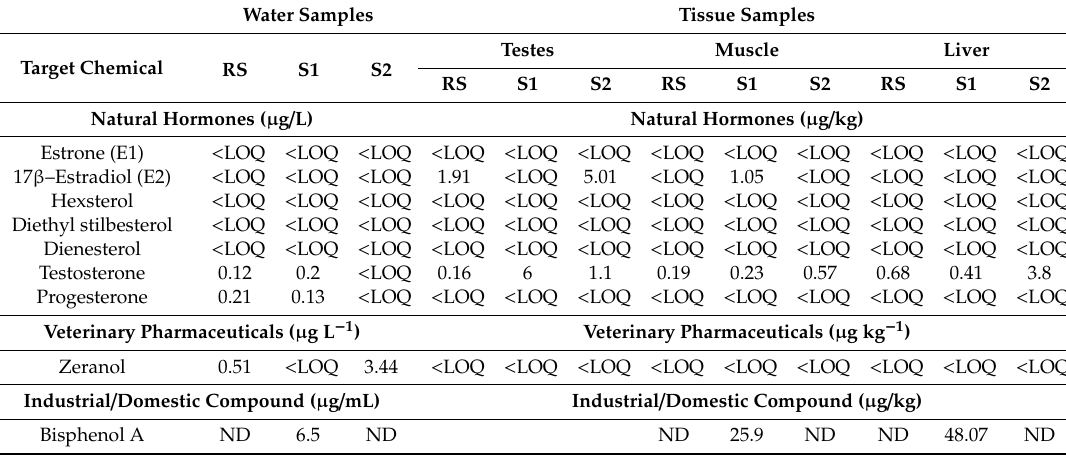
Table 1. Steroidal and phenolic endocrine disruptive chemicals (EDCs) in water ( µ g / L) and fish tissues ( µ g / kg) from sampling sites along the Bahr El-Baqar drainage (Egypt).